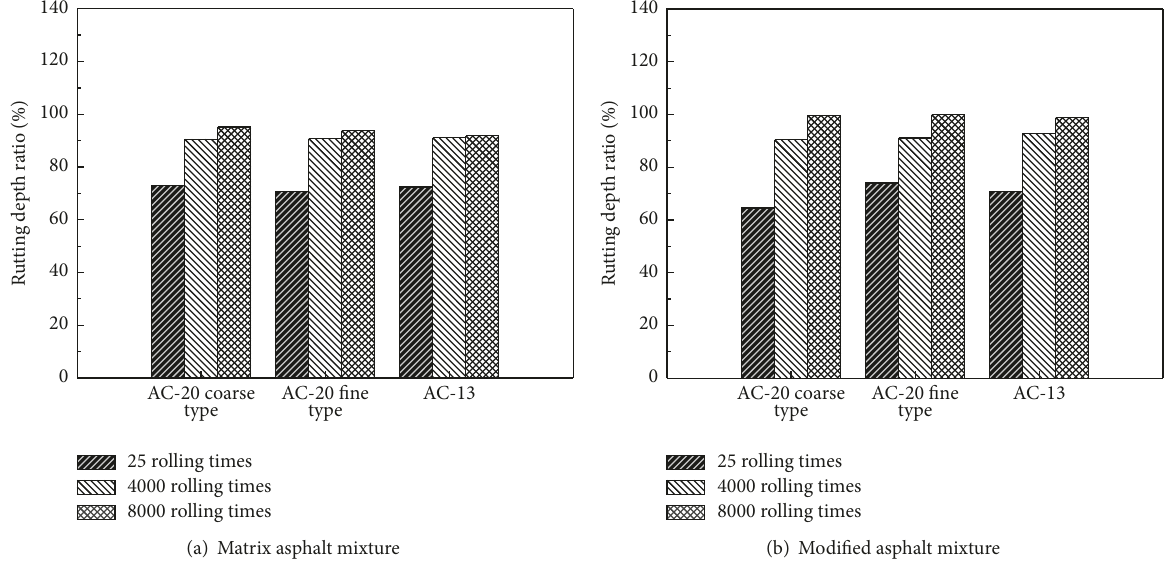
Figure 12: Rutting depth ratios of specimens with 4% air void at 50 ∘ C under different rolling times.